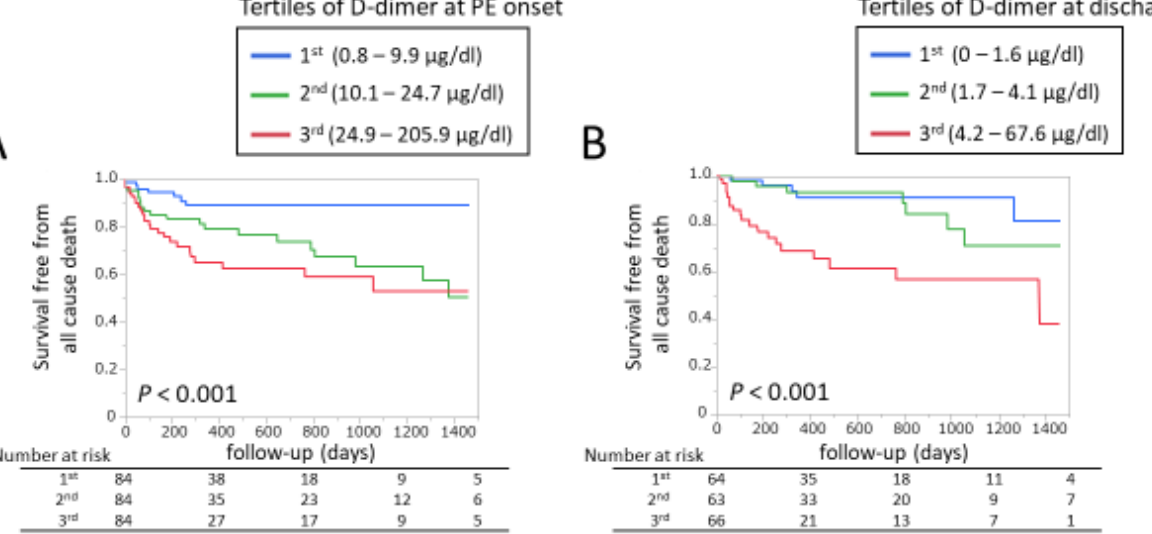
Figure 4. Kaplan–Meier curves for ( A ) all-cause death; ( B ) MACE defined as the composite of cardiovascular death, MI, and stroke; ( C ) the composite of MI and stroke; and ( D ) major bleeding in patients with malignancy and those without. MACE, major adverse cardiovascular events; MI, myocardial infarction.